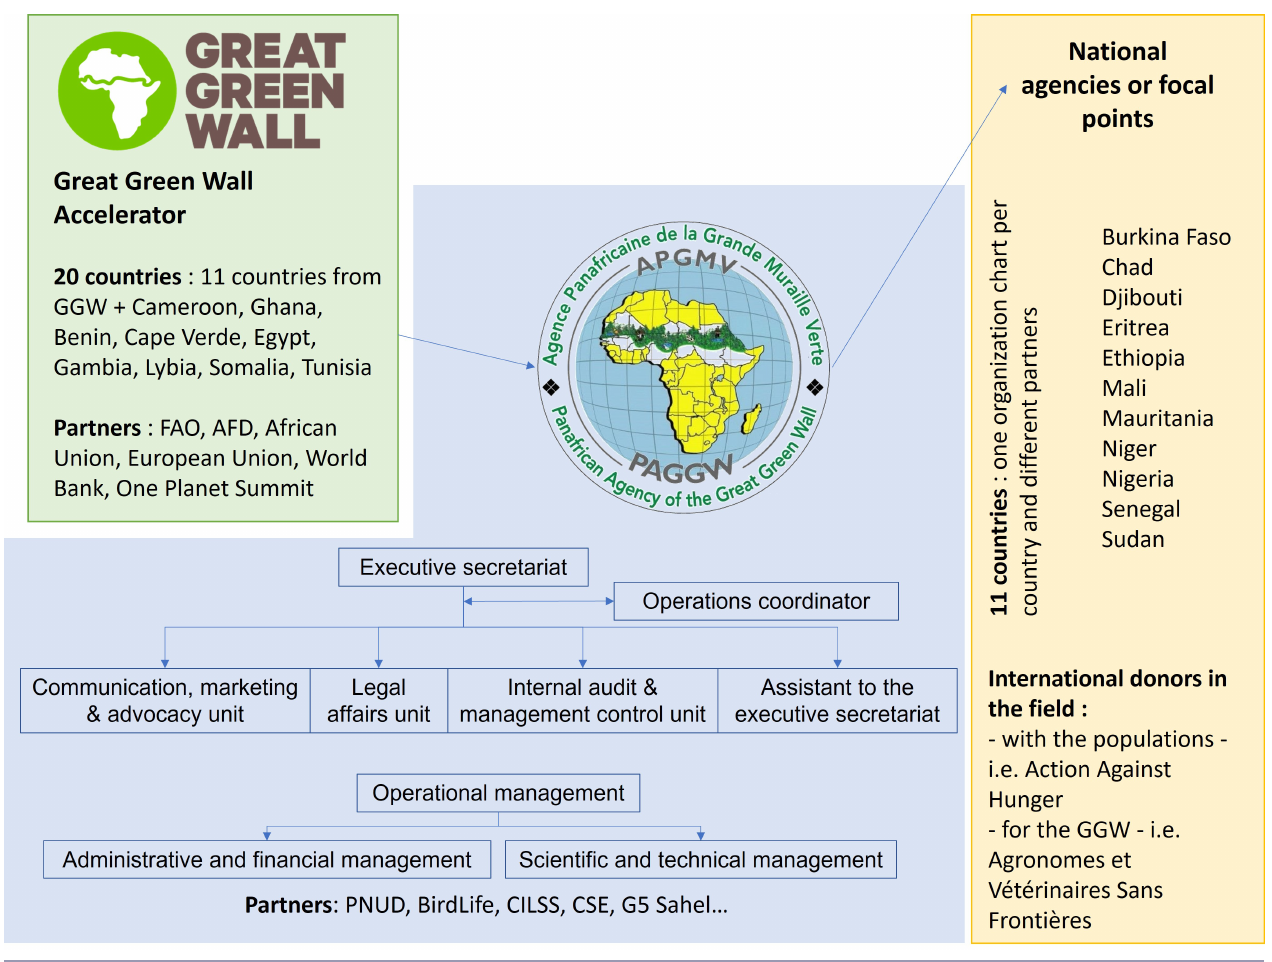
Fig. 1. Positioning of the Pan-African Agency of the Great Green Wall (PAGGW), local agencies of the Great Green Wall (GGW), and GGW